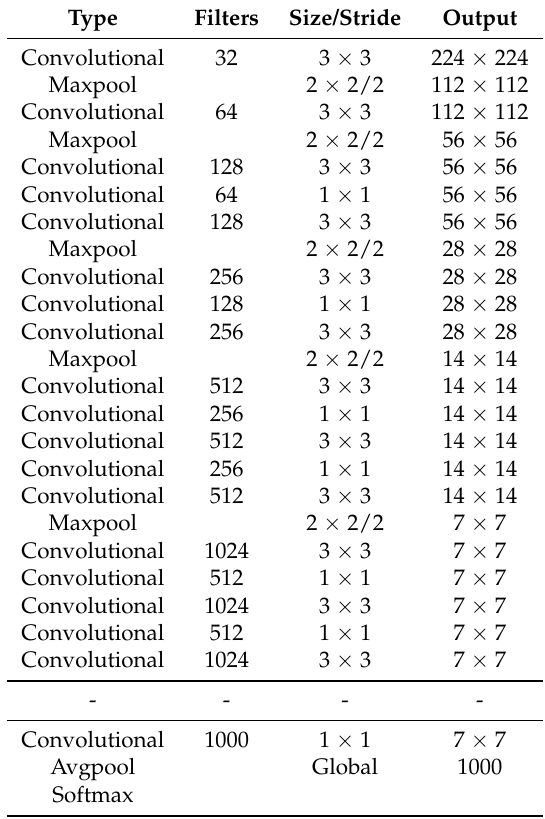
Table 1. YOLO 9000 Network’s Architecture Darknet-19